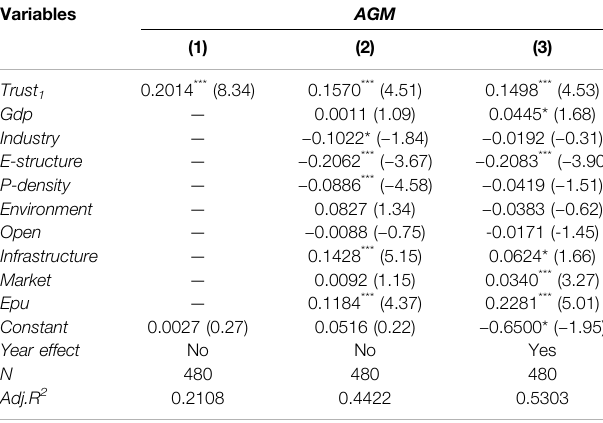
TABLE 4 | The effect of social trust on regional eco-ef fi ciency.